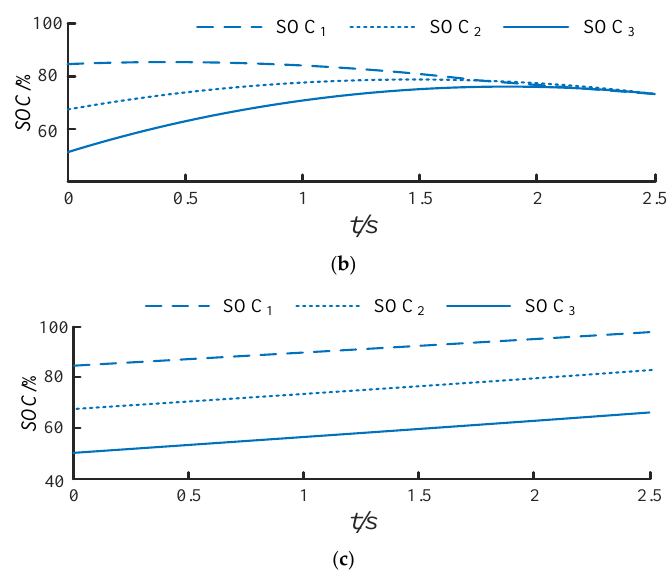
Figure 10. DESS charging simulation results. ( a ) Charging power under ESU equalization strategy. ( b ) Charging SOC under ESU equalization strategy. ( c ) Charging SOC under ESU traditional control strategy.